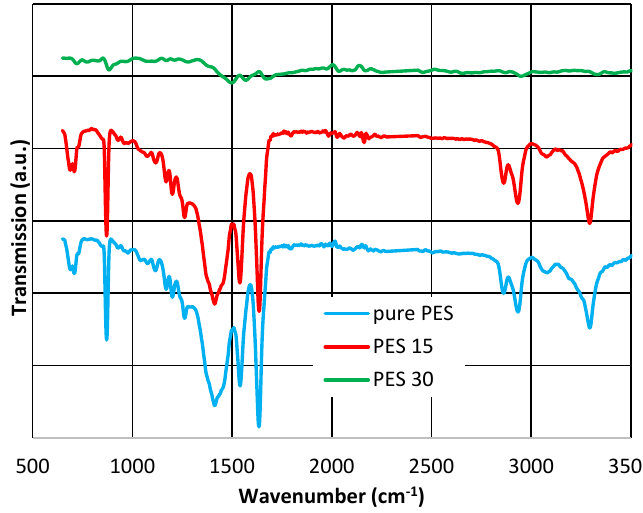
Figure 6. ATR-FTIR spectra: ( a ) pure PES; ( b ) PES15; and ( c ) PES30.